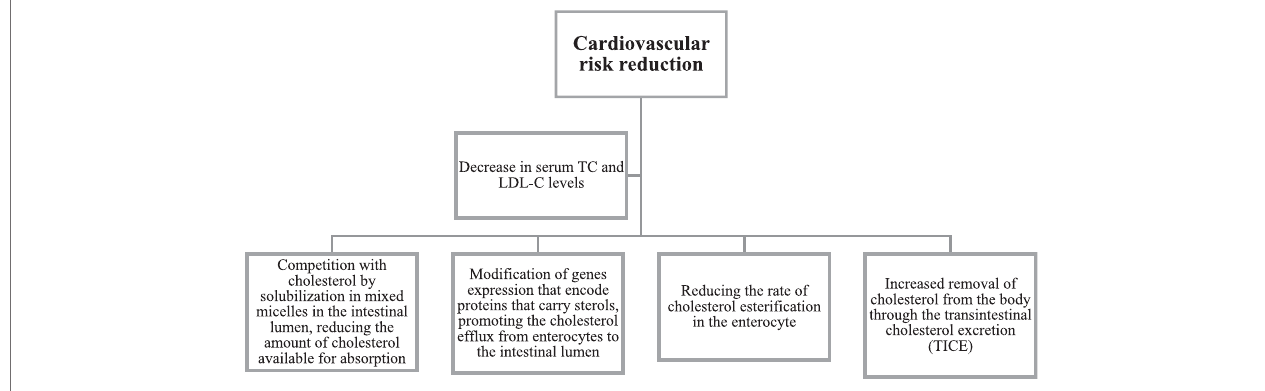
FIGURE 3 | Mechanism of action of phytosterols in reducing cardiovascular